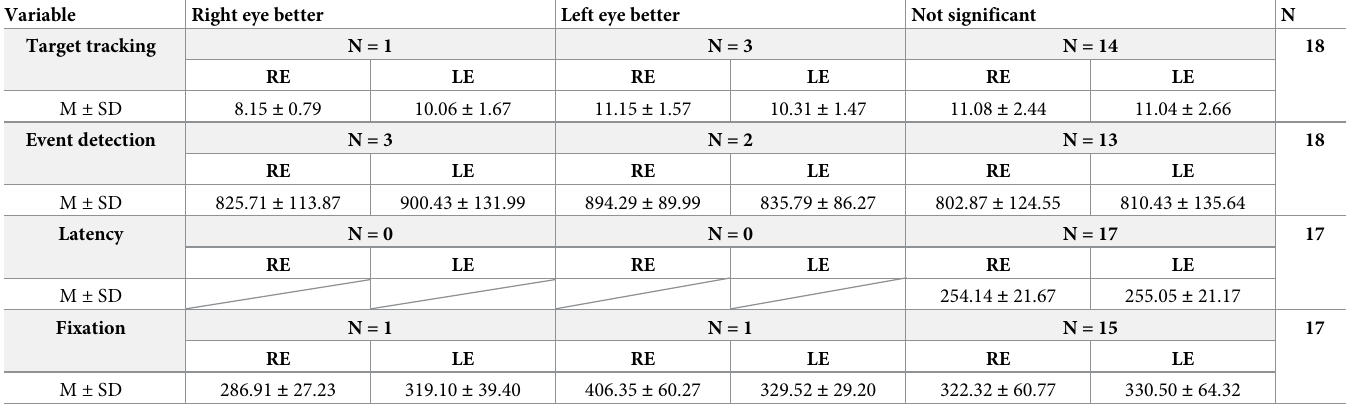
Table 1. Distribution of participants as a function of their best eye (RE = right eye; LE = left eye). Variable Right eye better Left eye better